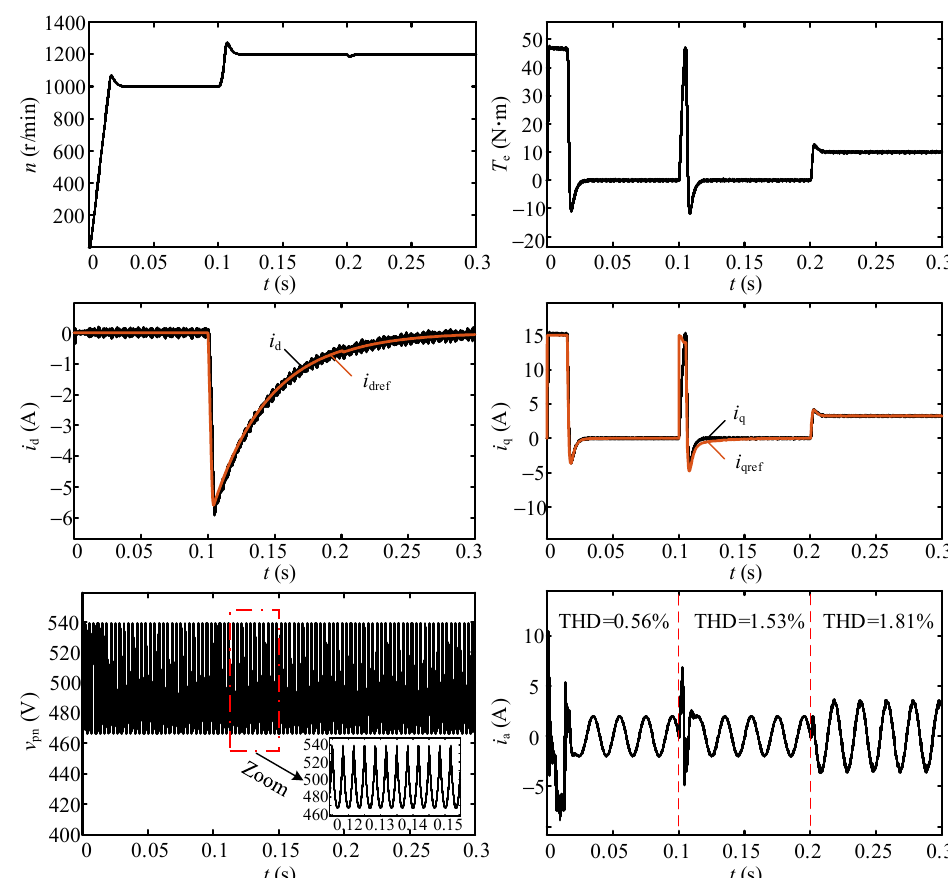
Figure 11. Simulation waveforms of operation Region A. In the figure, actual speed traces the reference well. The IMC is in the linear modulation region, and the rectifier stage keeps CASE 1 modulation. Total harmonic distortion (THD) of one of the input currents of Phase a of the IMC, i a , is 7.89%. Torque ripple of SPMSM is nearly the peak-to-peak value of 0.8 N · m with peak and valley values of 10.4 and 9.6 N · m.